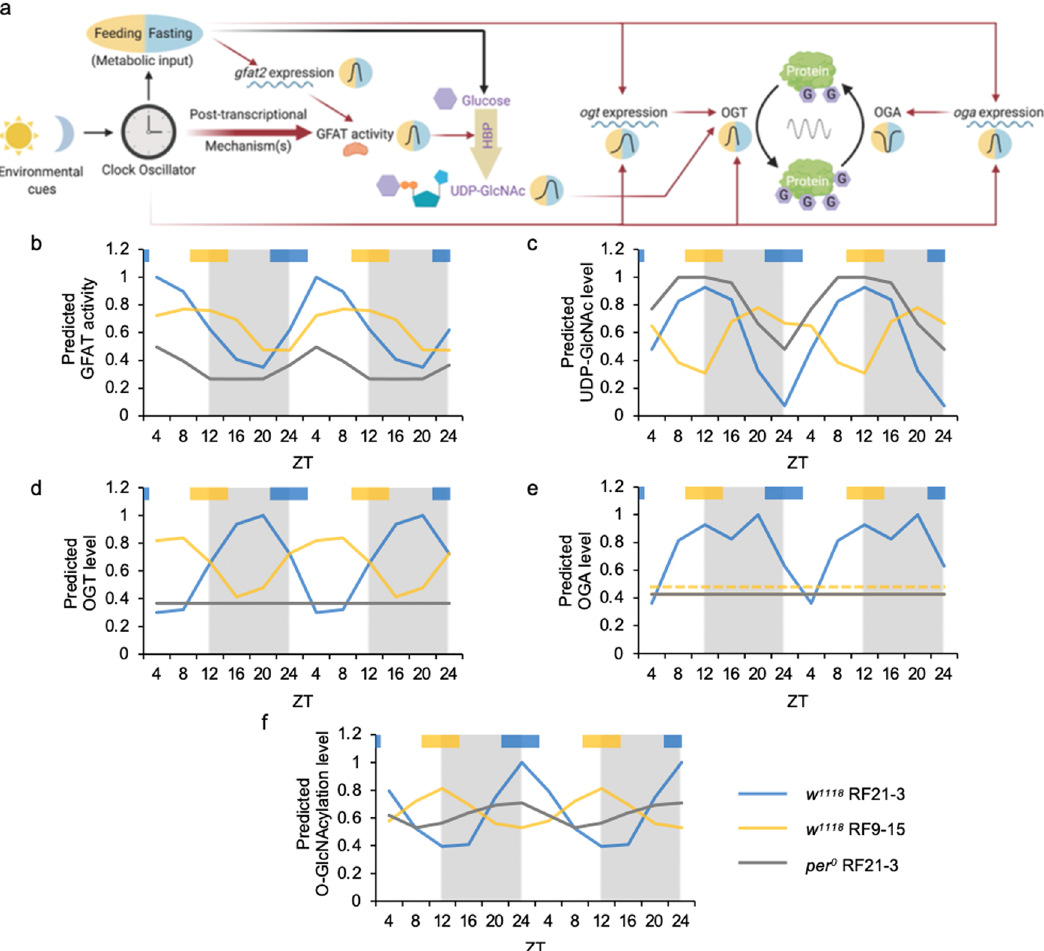
Fig. 7 A mathematical model to describe and predict daily protein O-GlcNAcylation rhythm based on molecular clock function and timing of food intake. a Schematic model showing the regulation of protein O-GlcNAcylation by the circadian clock through feeding activity and post-transcriptional mechanism(s). Yellow background indicates feeding period while the blue background indicates fasting period. Red arrows denote activation, and the thicker red arrows denote a stronger effect. b – f Line graphs showing daily rhythms of ( b ) GFAT activity, ( c ) UDP-GlcNAc, ( d ) OGT protein, ( e ) OGA protein and ( f ) protein O-GlcNAcylation levels as predicted using the mathematical model (Table 1). In ( e ), the predicted OGA protein levels are the same in WT RF9-15 and per 0 RF21-3 fl ies, and the two curves overlap in the graph. Therefore, a dashed line is used to indicate OGA level in WT RF9-15 group. Time of feeding for WT RF21-3, WT RF9-15 and per 0 RF21-3 fl y groups were used as input for the model and the circadian clock is assumed to be functional in WT but not in per 0 fl ies. Gray shading in graph area indicates the dark period of LD cycle. Colored bars at the top of graphs denote the feeding periods for TRF treatment groups, RF21-3 (blue) and RF9-15